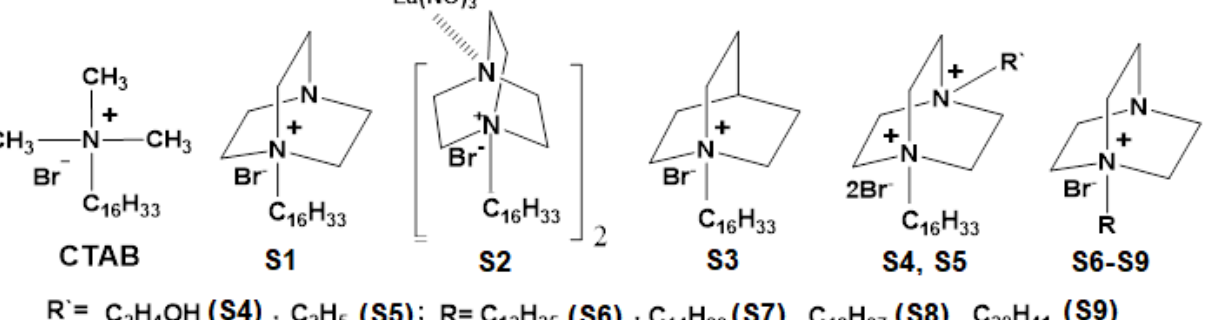
Figure 1. Structures of cetyltrimethylammonium bromide (CTAB), and quaternary derivatives of quinuclidine (S3) and of DABCO derivatives (S1, S2 and S4 to S9 surfactants) (Adapted from Ref. [17]). The choice of oils, surfactants, cationic lipids, polymers, isotonizing agents that are ophthalmically acceptable, is one of the most important steps to obtain a successful